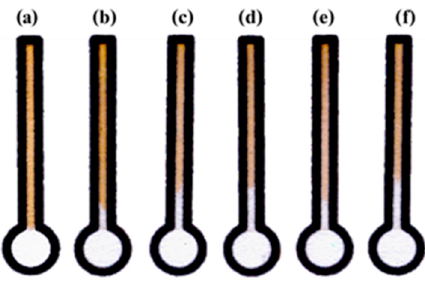
Figure 4. Effect of sample volume at ( a ) 0, ( b ) 25, ( c ) 50, ( d ) 75, ( e ) 100, and ( f ) 50 × 2 µL contained of CN − 10 mg L − 1 . CN − 10 mg L − 1